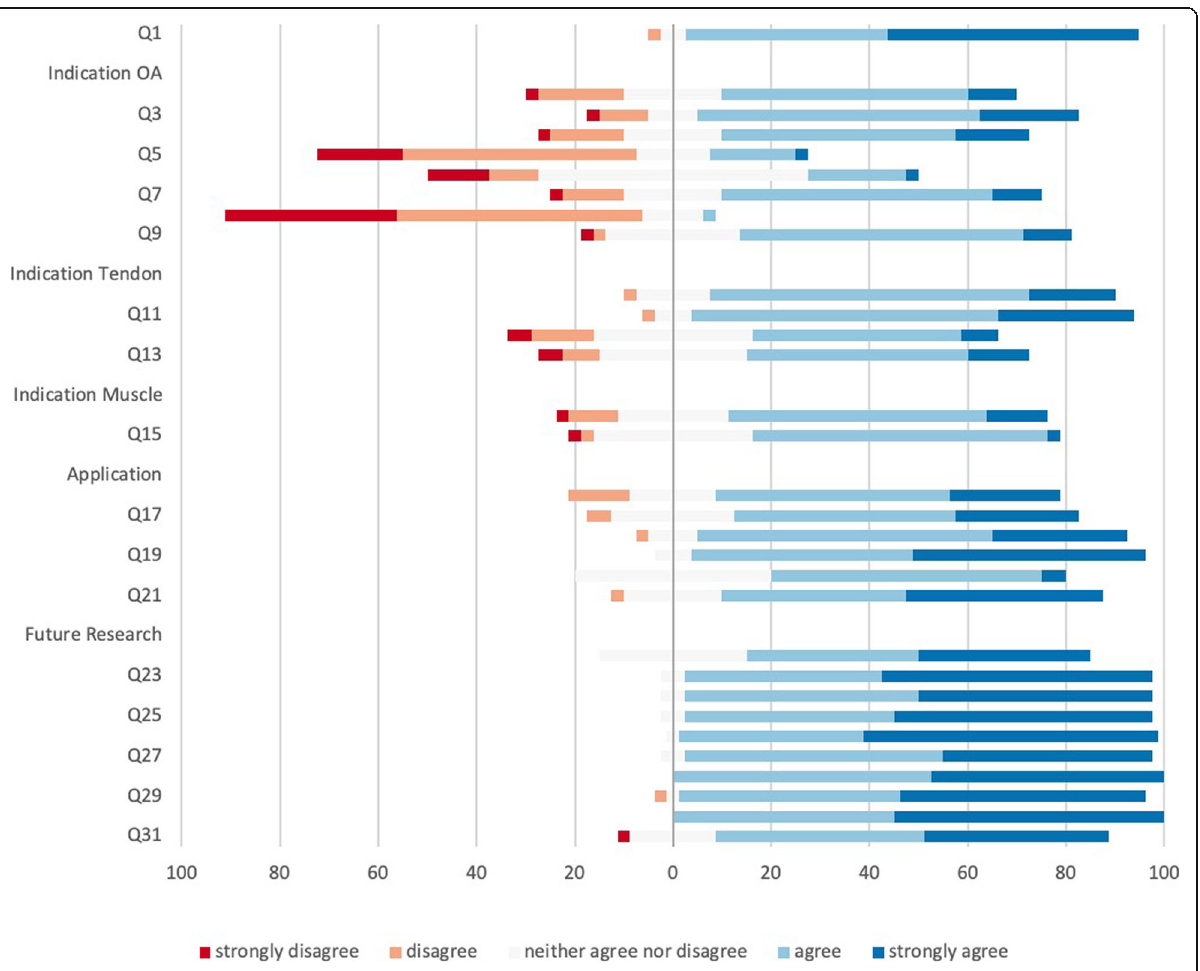
Fig. 2 Stacked leaning bar chart representing breakdown in agreement levels in the second survey round (31 questions (Q1 – Q31)), showing the areas with disagreement nicely. Bars to the left of the Y axis indicate disagreement with bars to the right indicating agreement. Most disagreement is seen in the field of